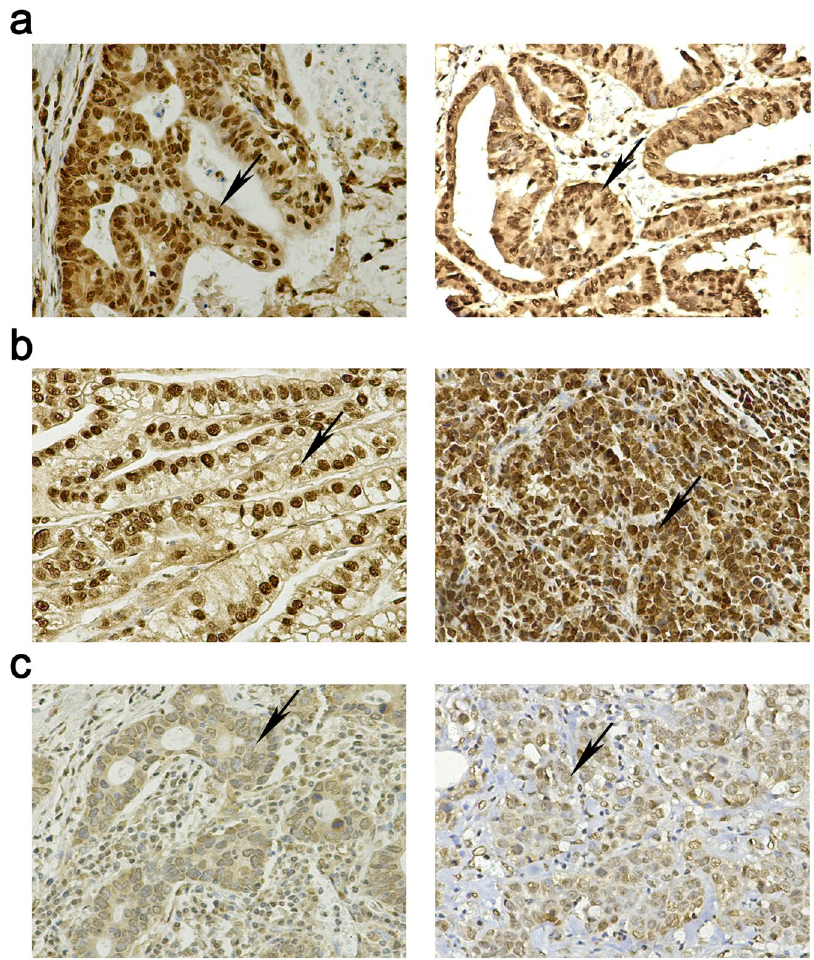
Figure 5. Representative images of HuR immunohistochemical staining in ( a ) the positive cytoplasmic expression group; ( b ) high nuclear expression group; ( c ) low nuclear group (400 ×